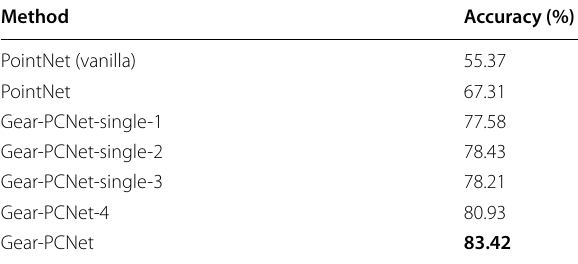
Table 3 Classification results of gear data